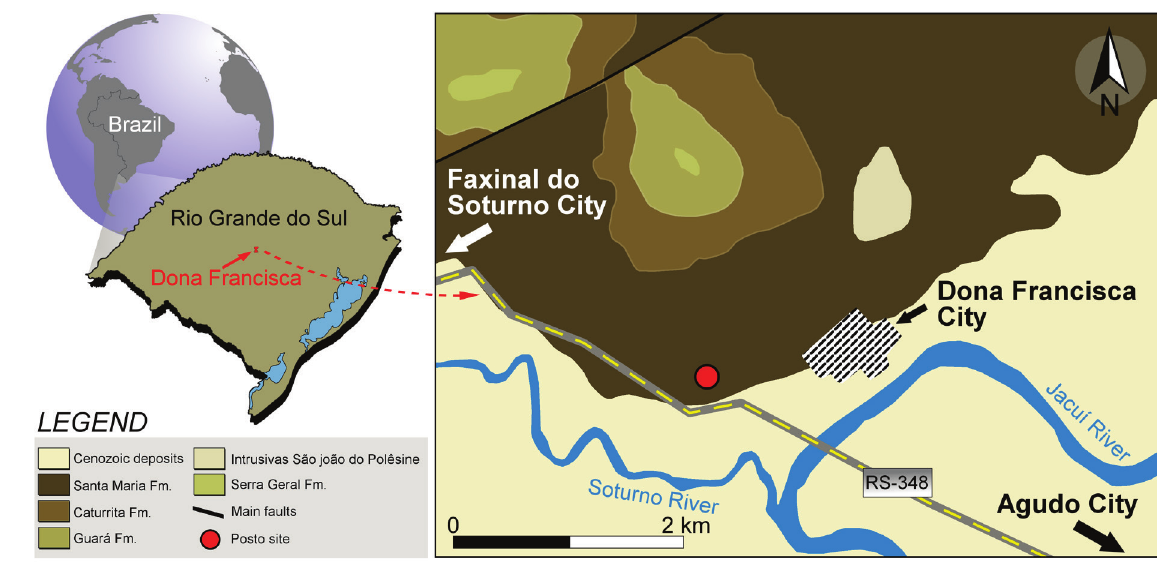
Figure 2 - Location of the “Posto Site” in the municipality of Dona Francisca in the Rio Grande do Sul State, Southern Brazil. Geological units according to Zerfass et al.